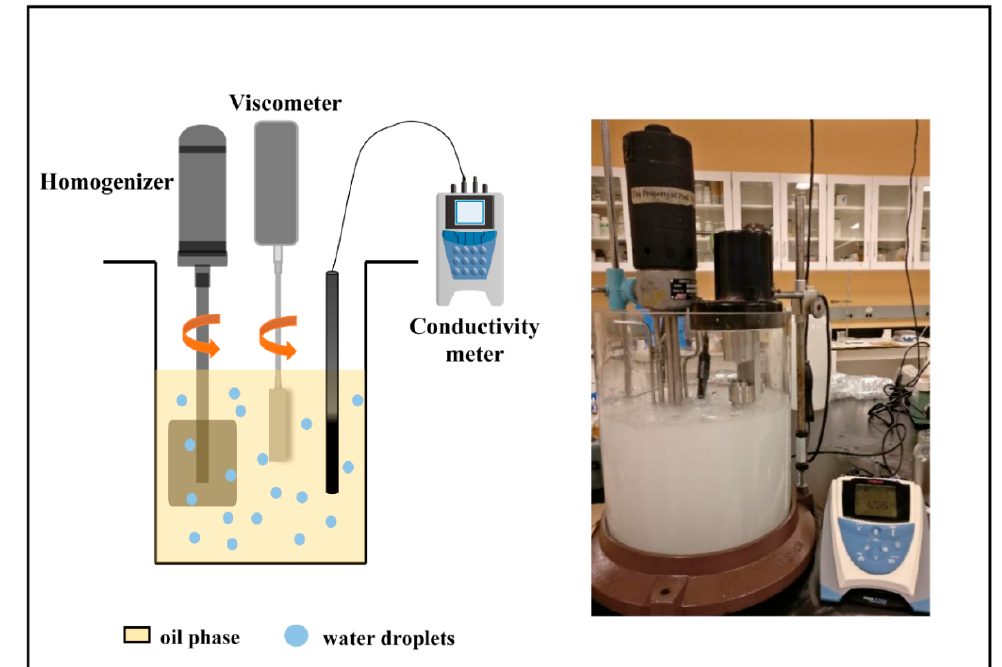
Figure 2. Schematic diagram and photograph of the experimental set-up for the in-situ measurement of the viscosity and conductivity of emulsions (adapted from [16]).